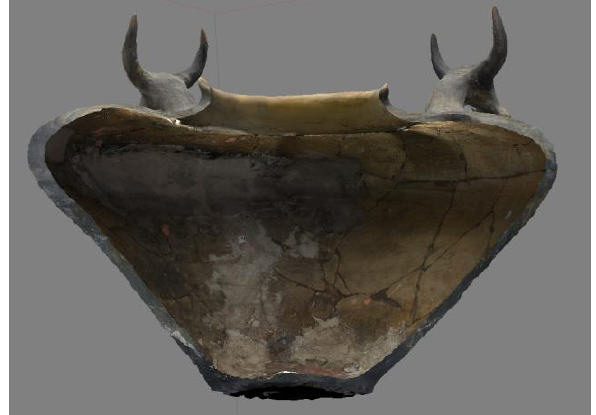
Figure 3: Cross-section of a 3d model of one of the artefacts; P0_inv19700